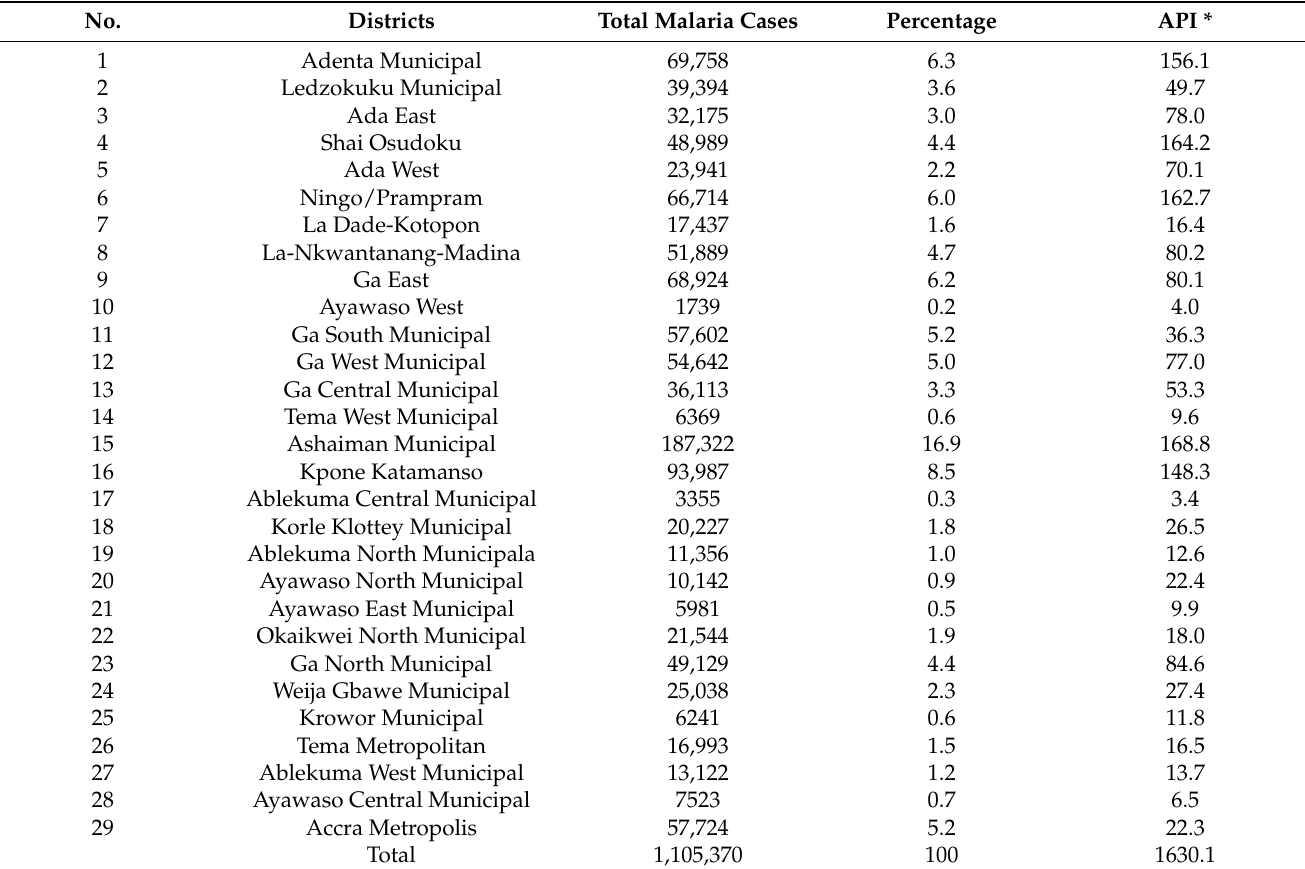
Table 1. Total malaria cases and API stratified by 29 districts (2015–2019).